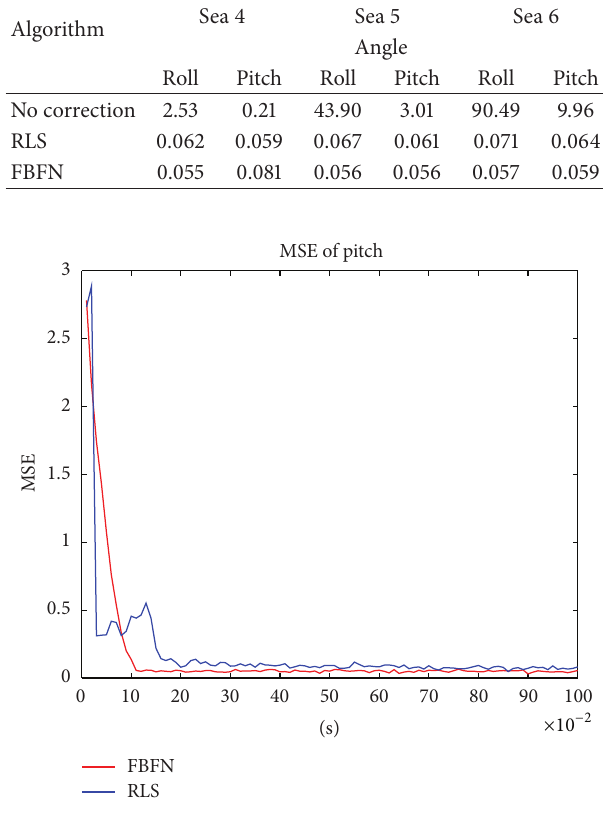
Figure 8: Beam pointing error correction for pitch